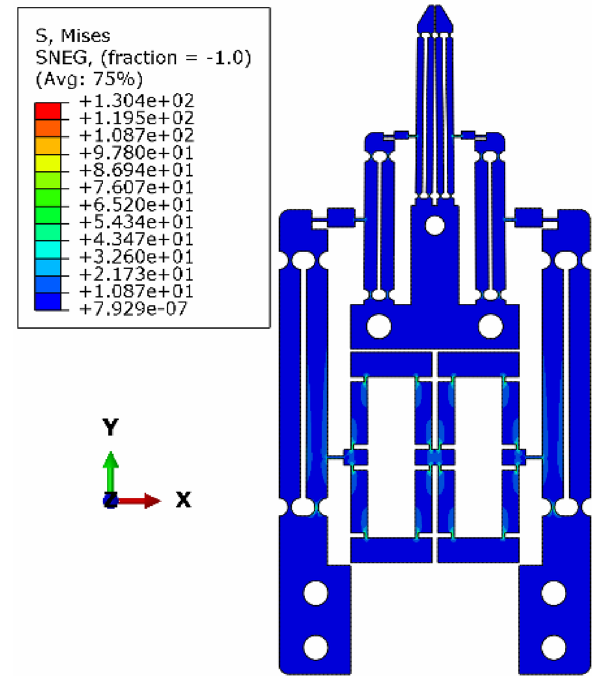
Fig. 4 FEA analysis diagram of the microgripper: stress nephogram of